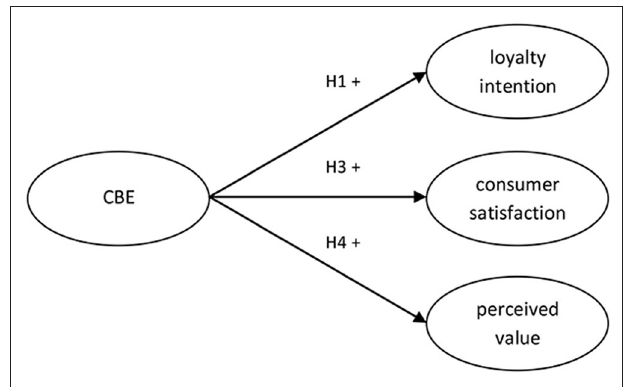
FIGURE 1 | Nomological net of selected CBE conceptual